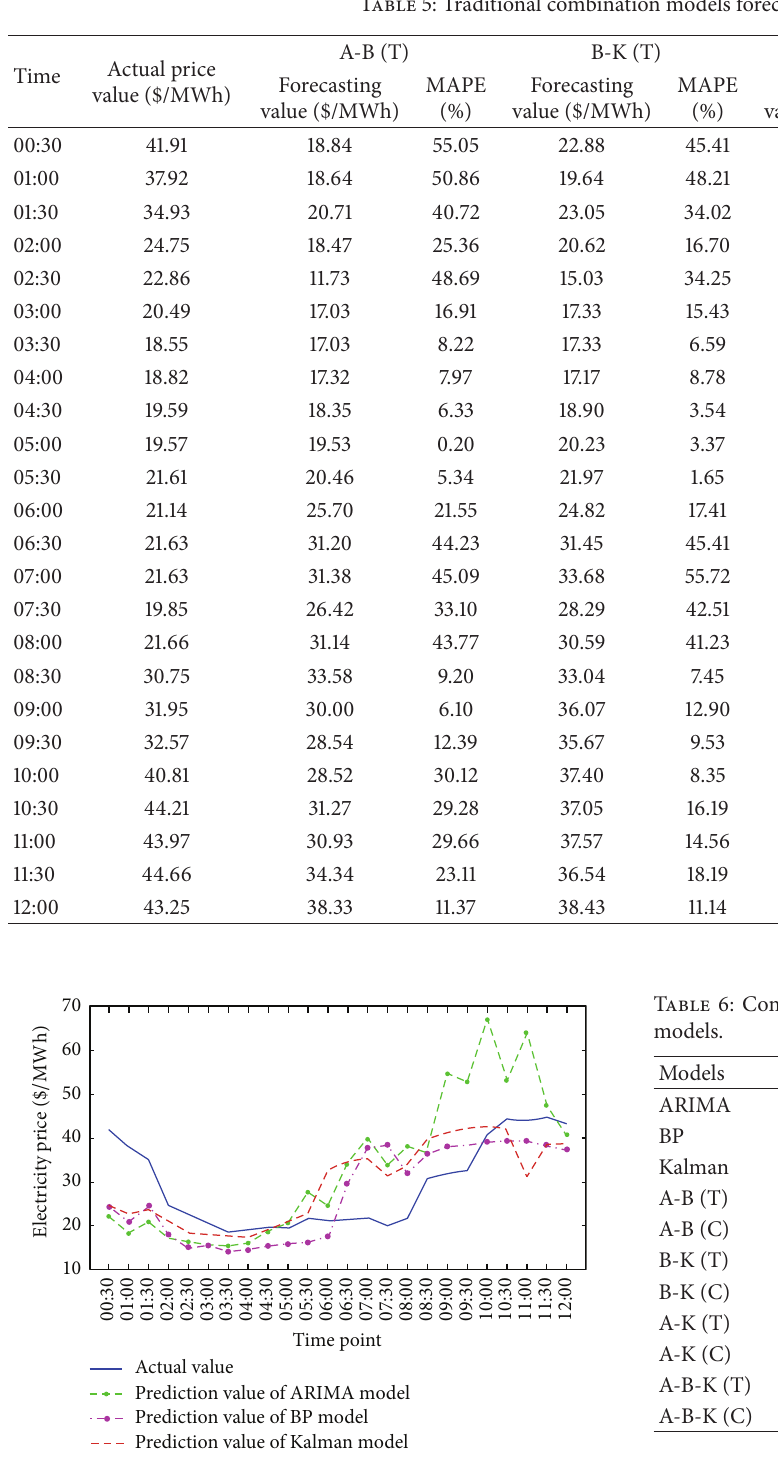
Figure 7: Comparison of the three individual forecasting results.